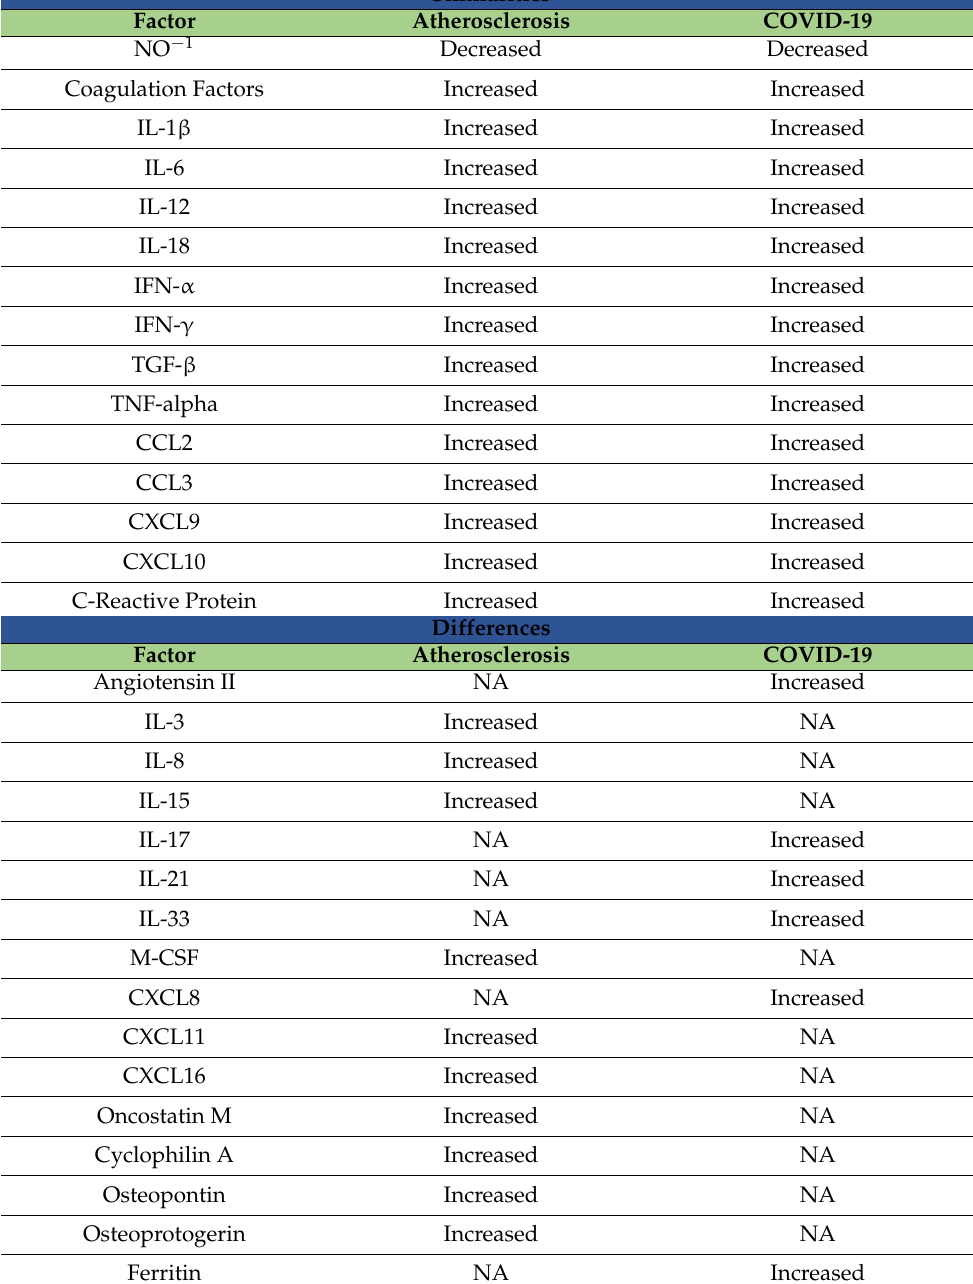
Table 2. Inflammation in Atherosclerosis and COVID-19—Similarities and